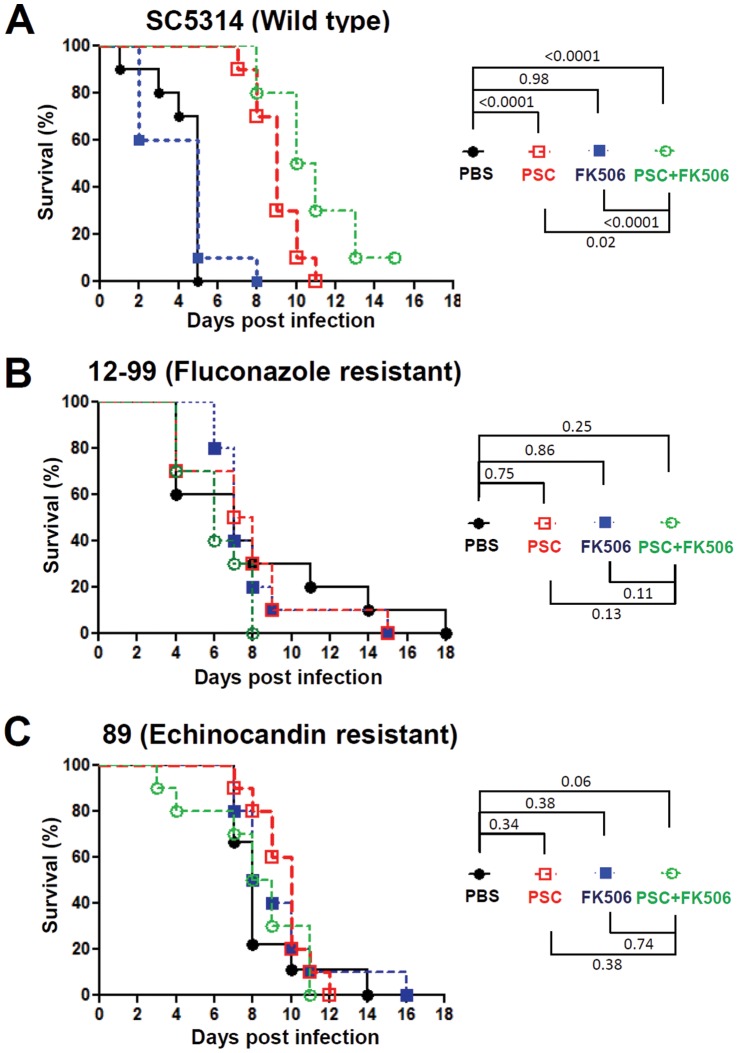
Efficacy of posaconazole and FK506 against C. albicans infection.Ten male CD1 mice (4–5 weeks-old) per group were infected with 106 cells of C. albicans SC5314, azole-resistant isolate 12–99, or echinocandin-resistant isolate 89, followed by treatment with placebo (PBS), posaconazole (PSC; 0.5 mg/kg), FK506 (0.5 mg/kg), or PSC (0.5 mg/kg) plus FK506 (0.5 mg/kg). The PSC was administered via oral gavage, while PBS and FK506 were administered via intraperitoneal injection at 4, 24, 48, and 72 hr post inoculation. Survival of the animals was monitored for up to 18 days.